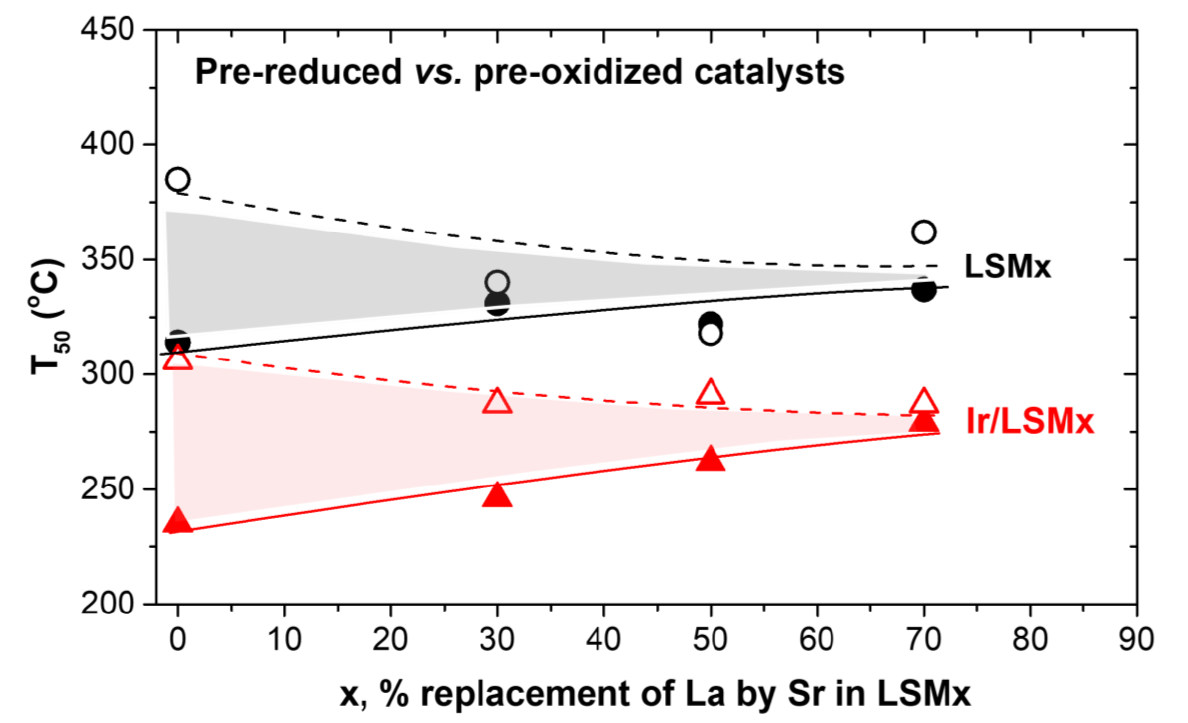
Figure 6. Activity limits in terms of T 50 between prereduced (solid lines and symbols) and preoxidized (dashed lines and open symbols) LSMx (black lines and symbols) and Ir/LSMx (red lines and symbols) catalysts obtained from the light-off catalysts’ performance of Figure 3.